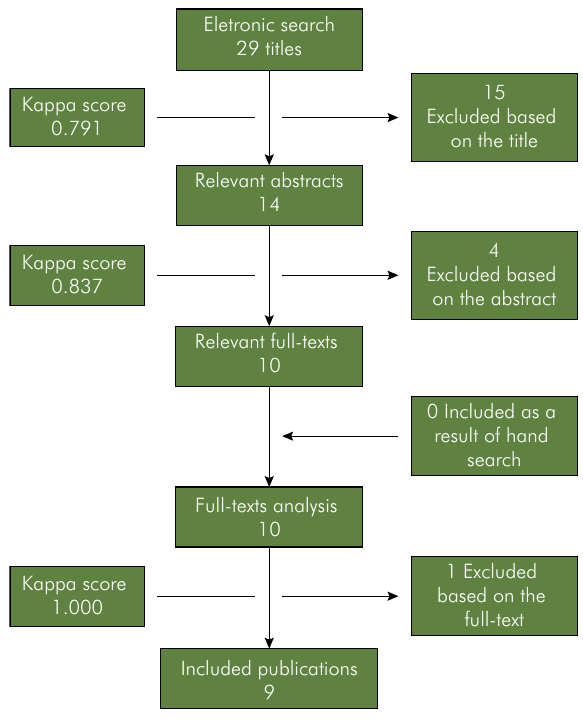
Figure 1. Simplified search strategy outline.